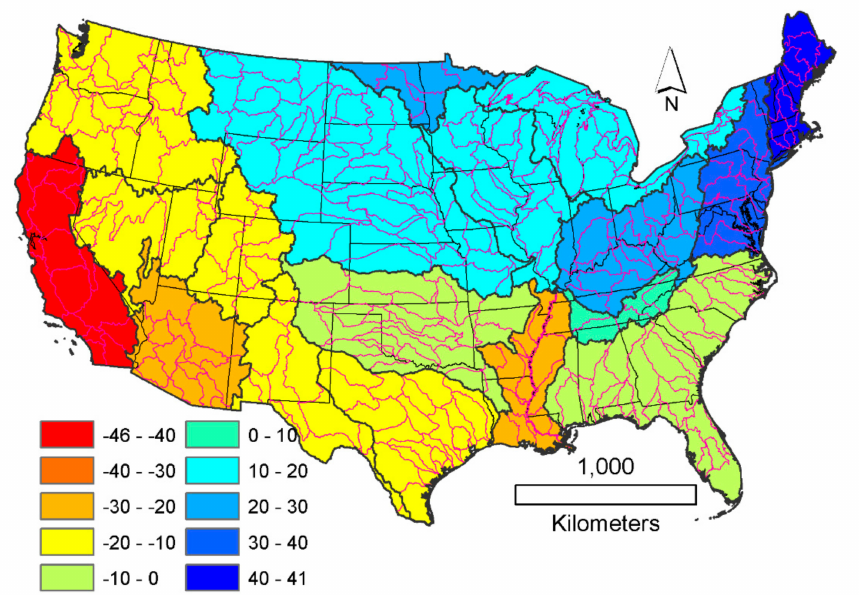
Figure 11. Spatial distribution of the linear tendencies (mm dec − 1 ) in the HUC2 annual PRISM precipitation rates (1979–2015).